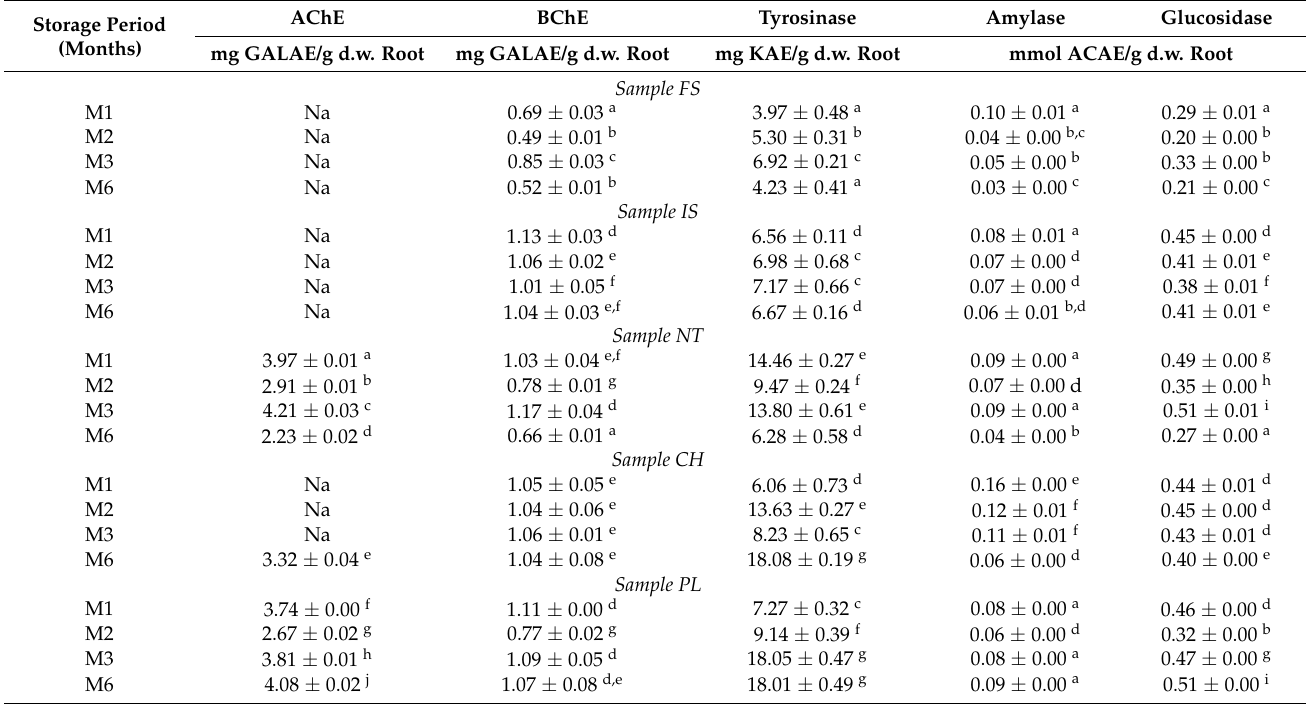
Table 4. Assessment of the enzyme inhibitory activity of comfrey ( S. officinale ) roots collected from different European regions and stored for 1–6